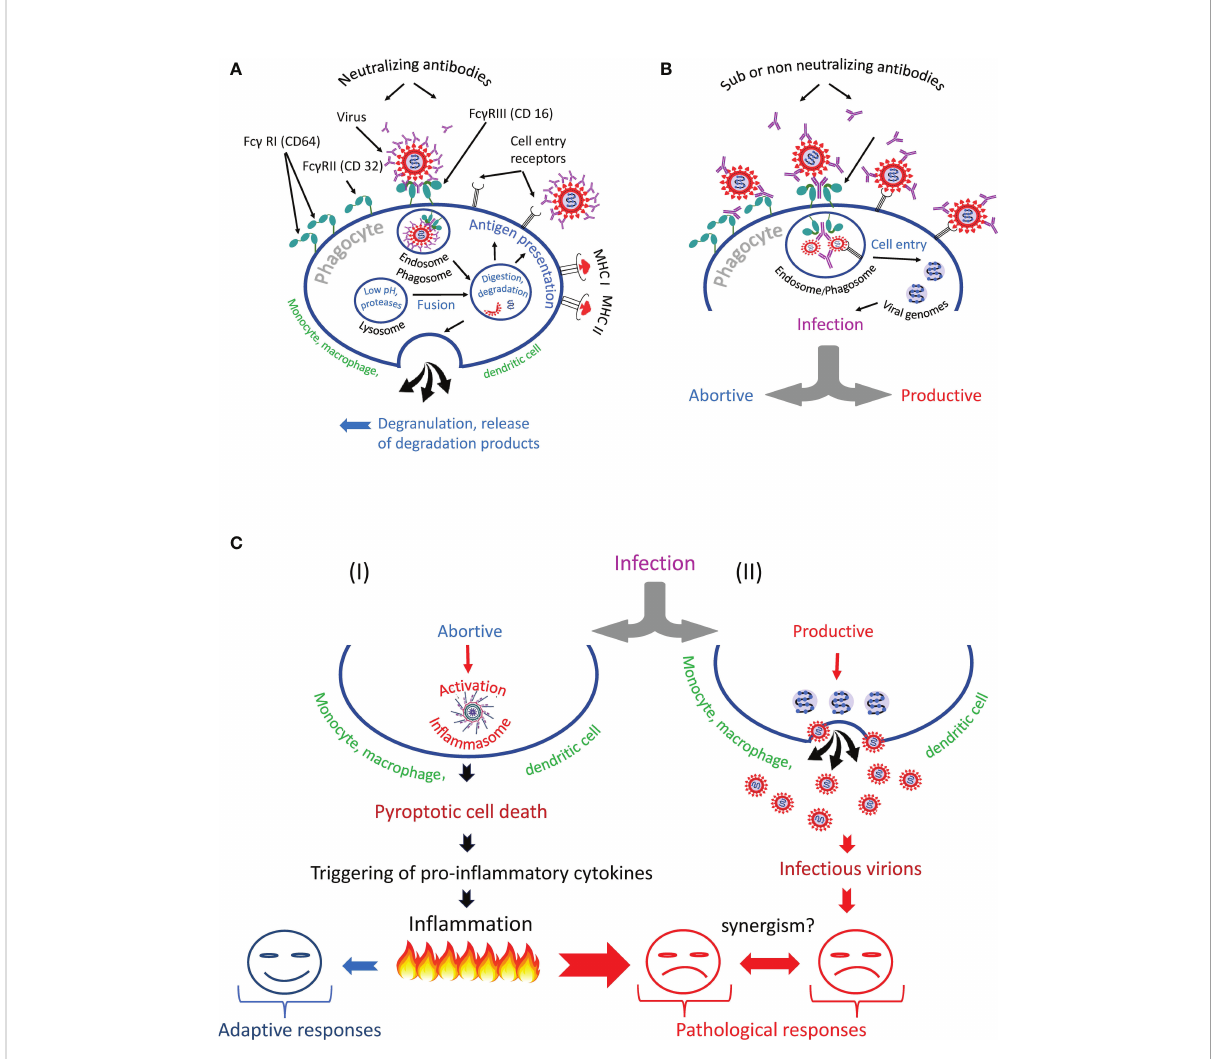
FIGURE 6 Antibody-dependent phagocytosis of SARS-CoV-2 in norm and pathology. (A) The phagocyte destroys the internationalized pathogen through the phagolysosomal pathway and presents its antigens via the major histocompatibility complexes (MHC I and MHC II). (B) The phagocyte engulfs but cannot inactivate SARS-CoV-2 and becomes infected. It is likely that the infection occurs due to the synergistic action of cell entry receptors and Fc receptors. (C) The virus escapes from the endosome/phagosome and the escape results in (I) abortive or (II) productive viral